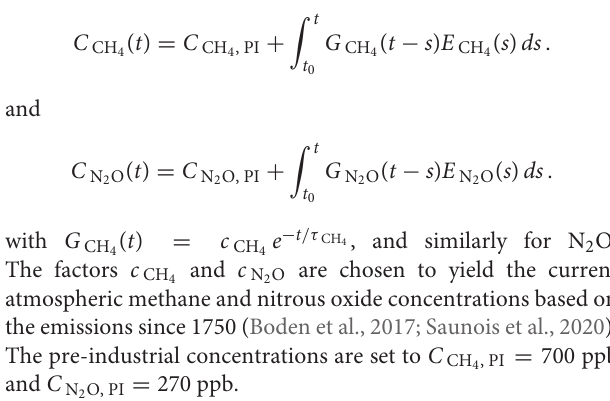
TABLE 3 | Overview of the model parameters used to compute greenhouse gas concentrations, greenhouse forcing, and aerosol forcing, following the approaches in Smith et al. (2018) and Leach et al.